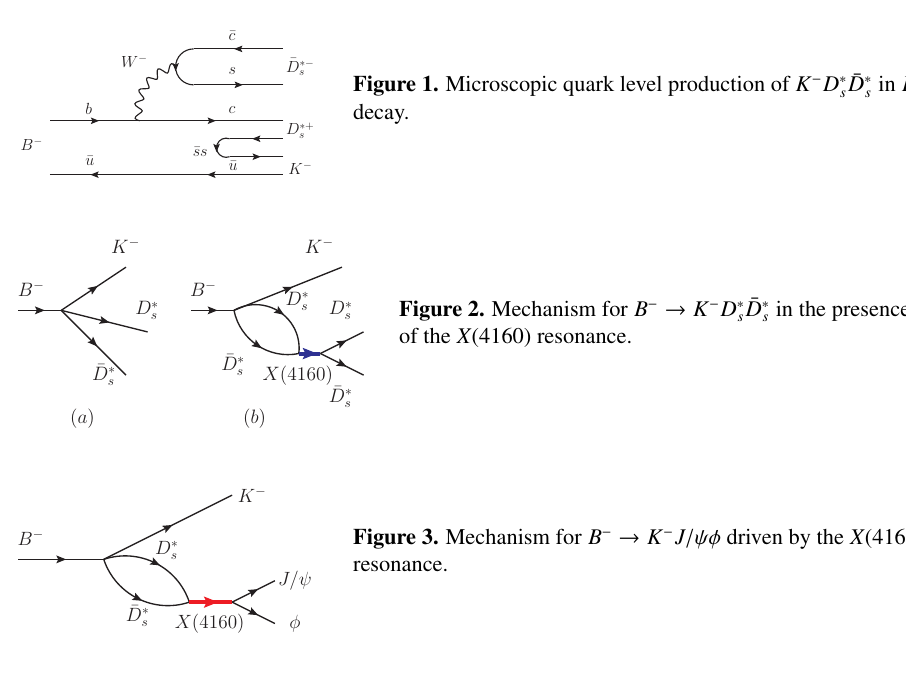
Figure 3. Mechanism for B − → K − J /ψφ driven by the X (4160)